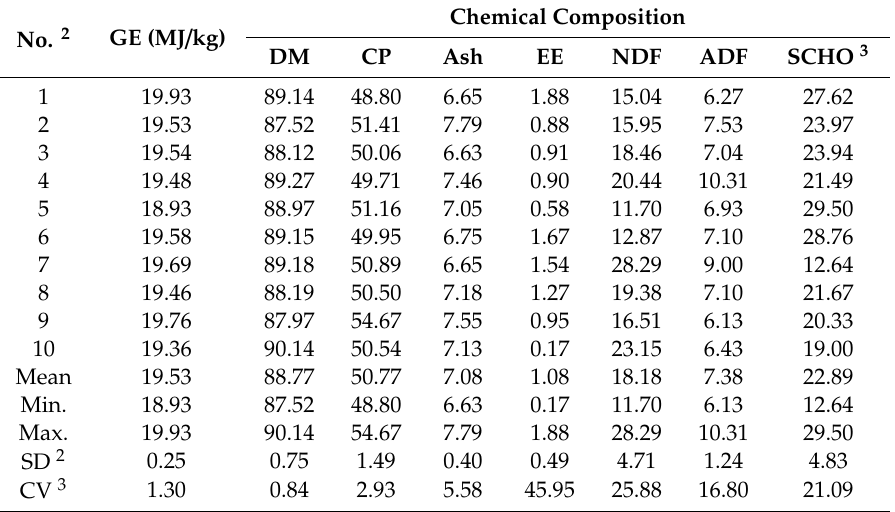
Table 4. Analyzed chemical composition of soybean meal (%, DM basis) 1